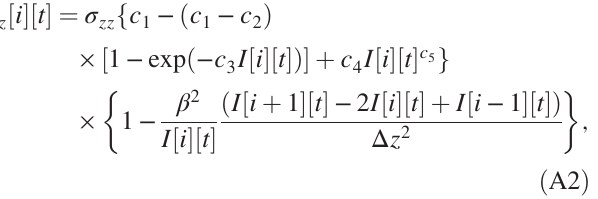
as a function of the loc for different values of β for app z Þ , obtained x ð